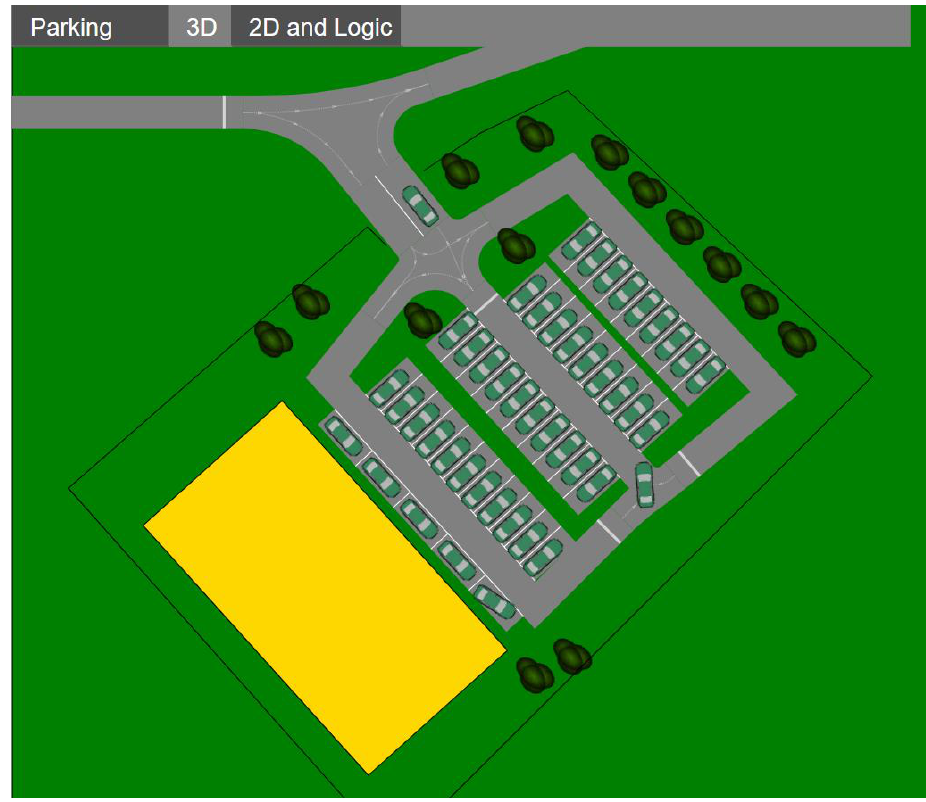
Figure 5. The 2D model animation.